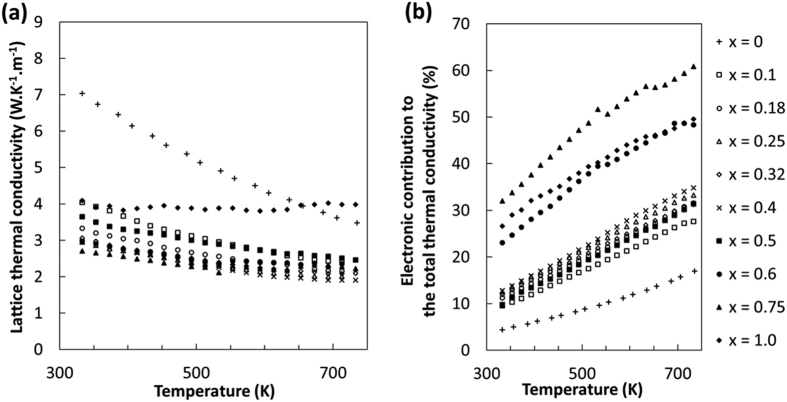
Thermal transport properties of CoSbS1−xSex doped with Te.(a) Lattice thermal conductivity as a function of temperature,(b) electronic contribution of the total thermal conductivity as a function of temperature.